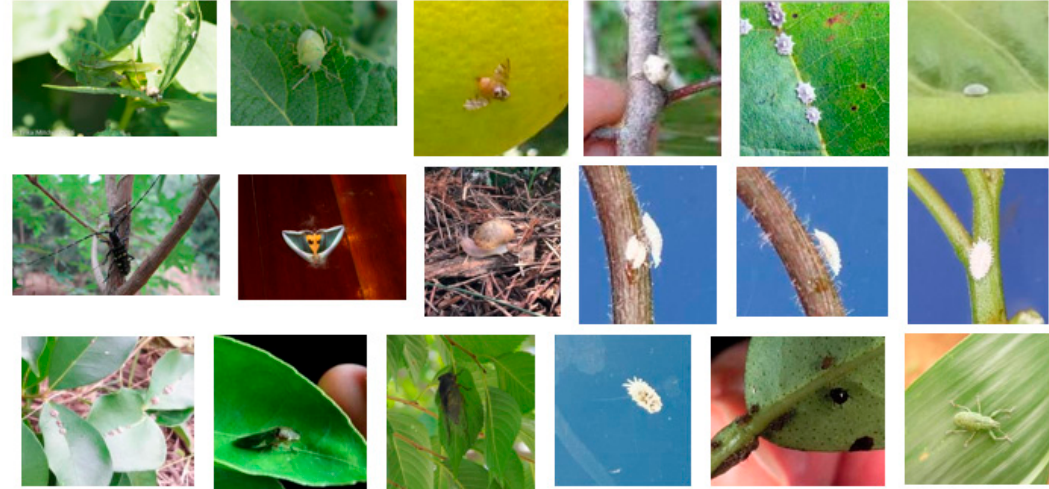
Figure 13. Examples of images misclassified by Weakly DenseNet-19: only images that were misclassified due to the small subject size are presented.